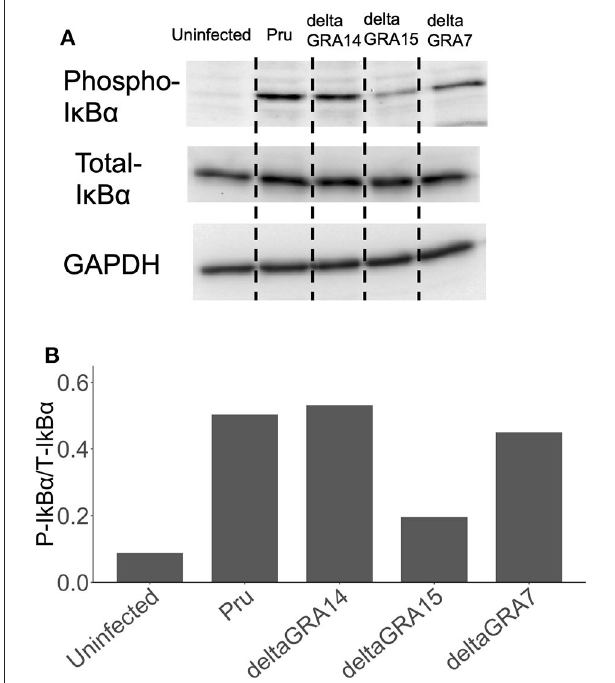
FIGURE 4 | Levels of phosphorylated I κ B α in HFF cells infected with T. gondii strains. (A) HFF cells were infected with parasite strains for 24h, then cell lysates were collected, separated on an SDS-PAGE gel, and western blot analysis was carried out with anti-phospho-I κ B α , total I κ B α , and GAPDH (host cell loading control) antibodies. (B) The ratio of phospho-I κ B α /total I κ B α in cells stimulated with parasites and uninfected cells. This experiment was repeated twice with similar results.